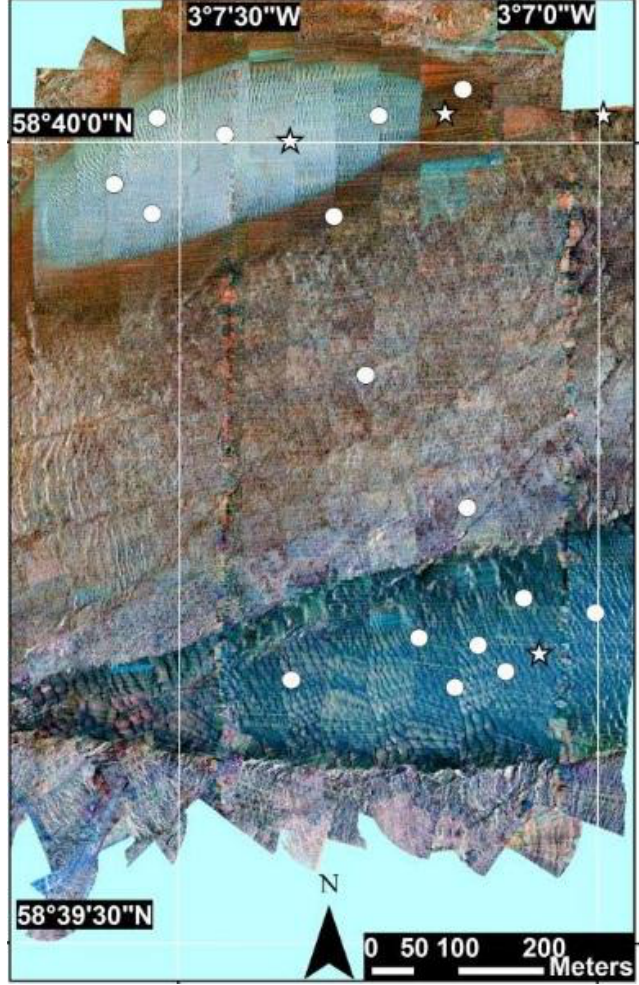
Figure 2. Positions of grab samples ( circles ) and positions of remotely-operated-vehicle (ROV) snapshots ( stars ).